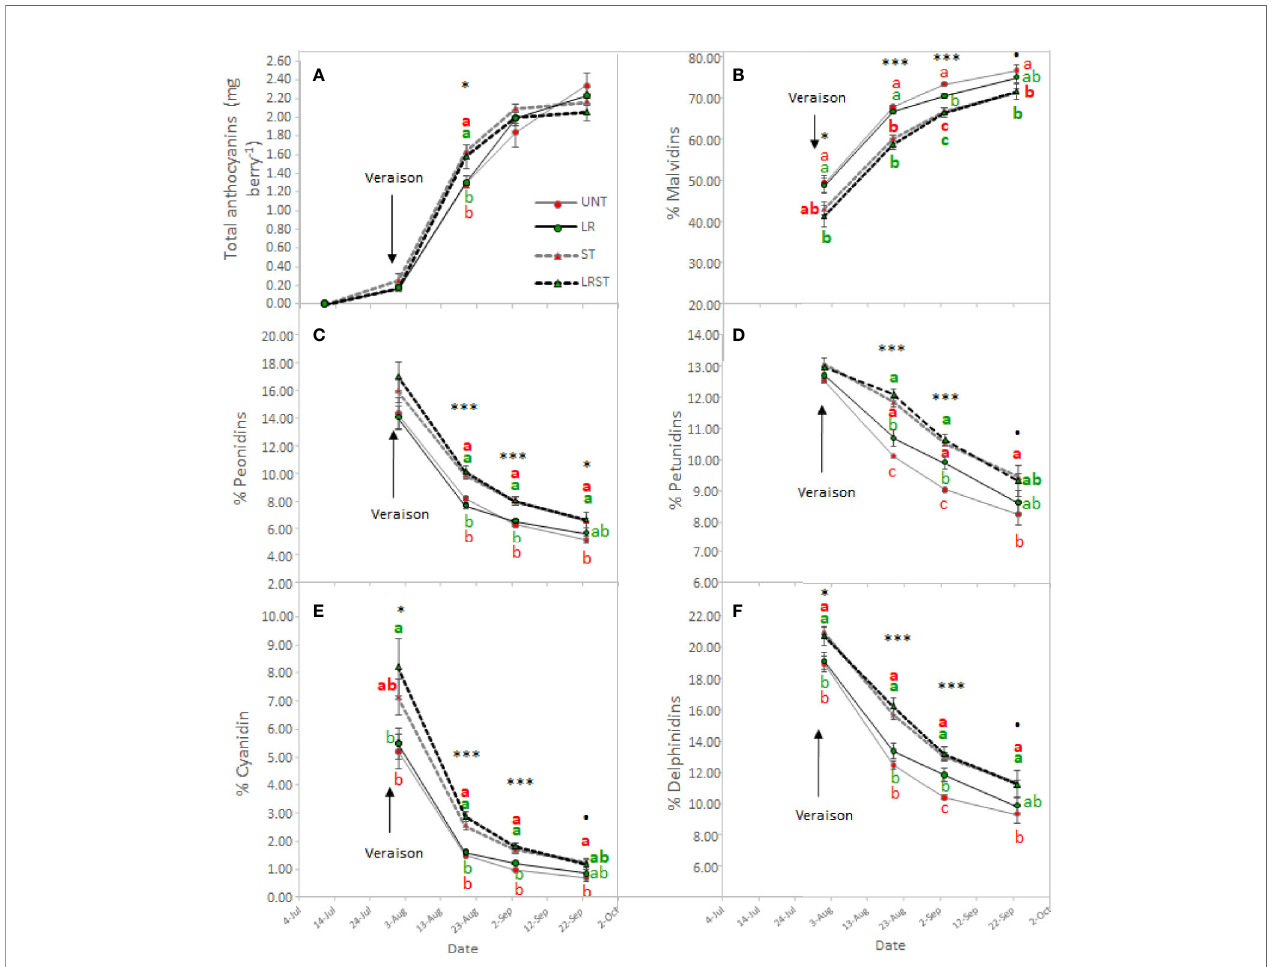
FIGURE 4 | Effect of canopy management practices (UNT, Untreated; LR, Leaf removal; ST, Shoot thinning; LRST, LR and ST combined) on berry skin anthocyanin content (A) , percent Malvidin (B) , percent Peonidin (C) , percent Petunidin (D) , percent Cyanidin (E) and percent Delphinidin (F) during the growing season. Values represent means ± SE (n = 4). At each time point, different letters indicate signi fi cant differences ( p < 0.05) between canopy management practices according to the one-way ANOVA followed by Duncan's new multiple range test. ·, *, and *** indicate signi fi cance at 10%, 5%, and 0.1% probability levels,